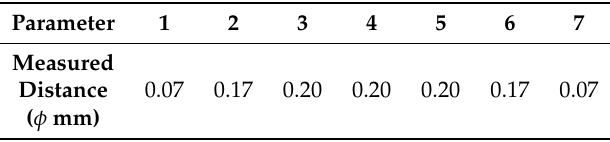
Table 2. Wheel arch pressure tappings: lateral measured